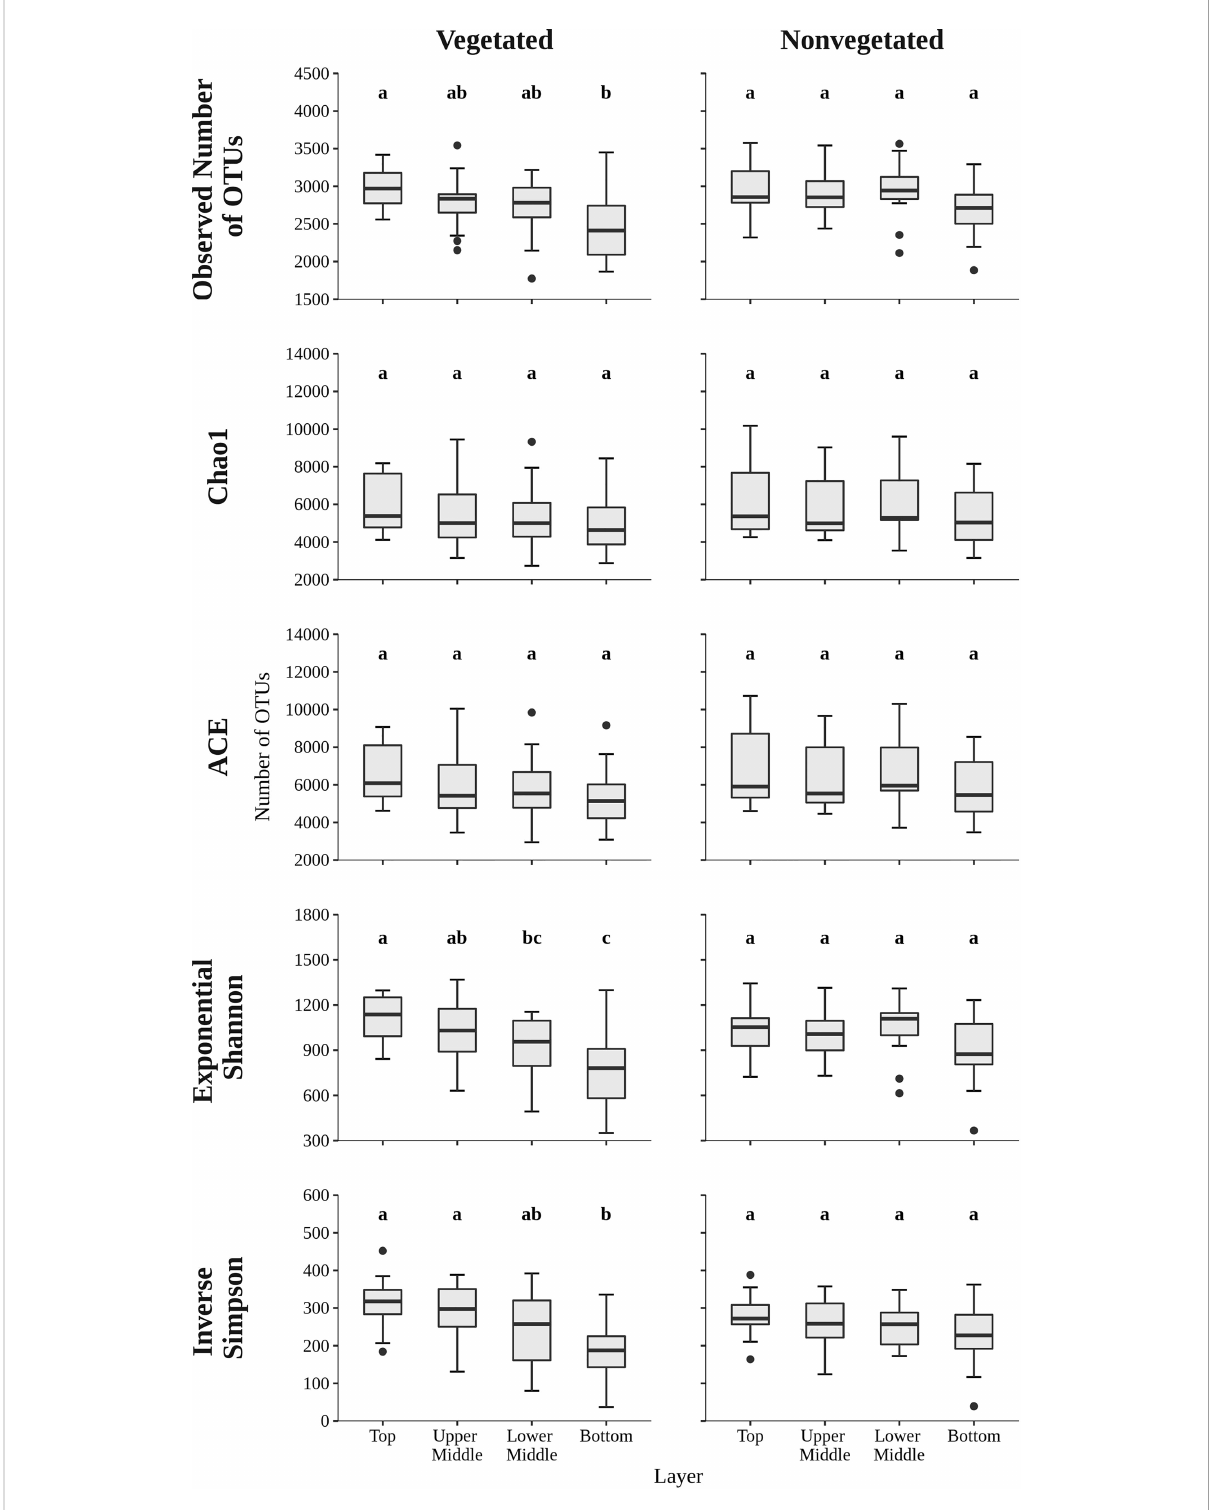
FIGURE 2 The observed number of OTUs, Chao1, ACE, exponential of the Shannon diversity index, and Inverse Simpson diversity index of sediment microbial communities sampled in different sediment layers of the vegetated and nonvegetated site in the Bay of Saline. Different letters correspond to statistically signi fi cant